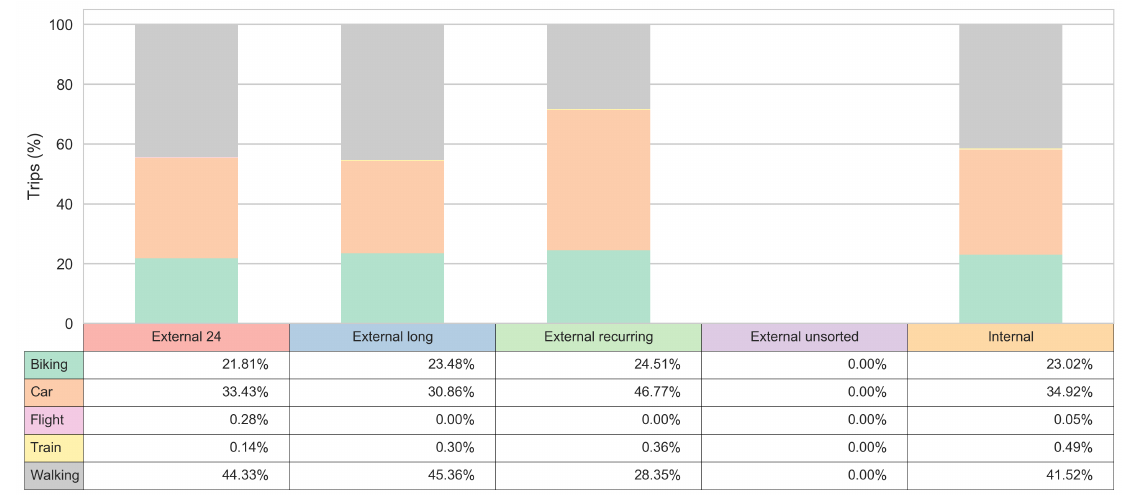
Figure 9. Transport mode choices by tourist segment.